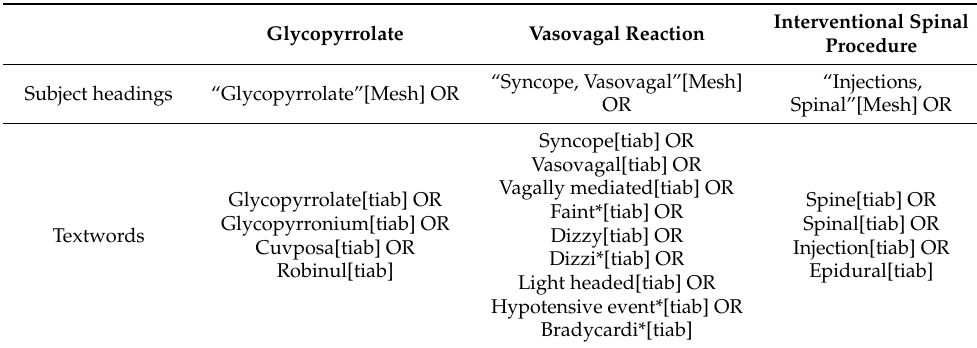
Table 1. Search methods on PubMed for glycopyrrolate as a preventive measure for vasovagal syncope from interventional pain management